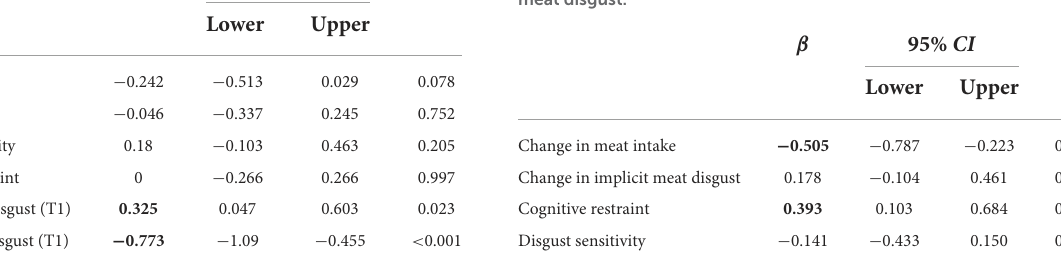
TABLE 3 Coefficients from multiple regression on changes in (explicit) meat disgust.